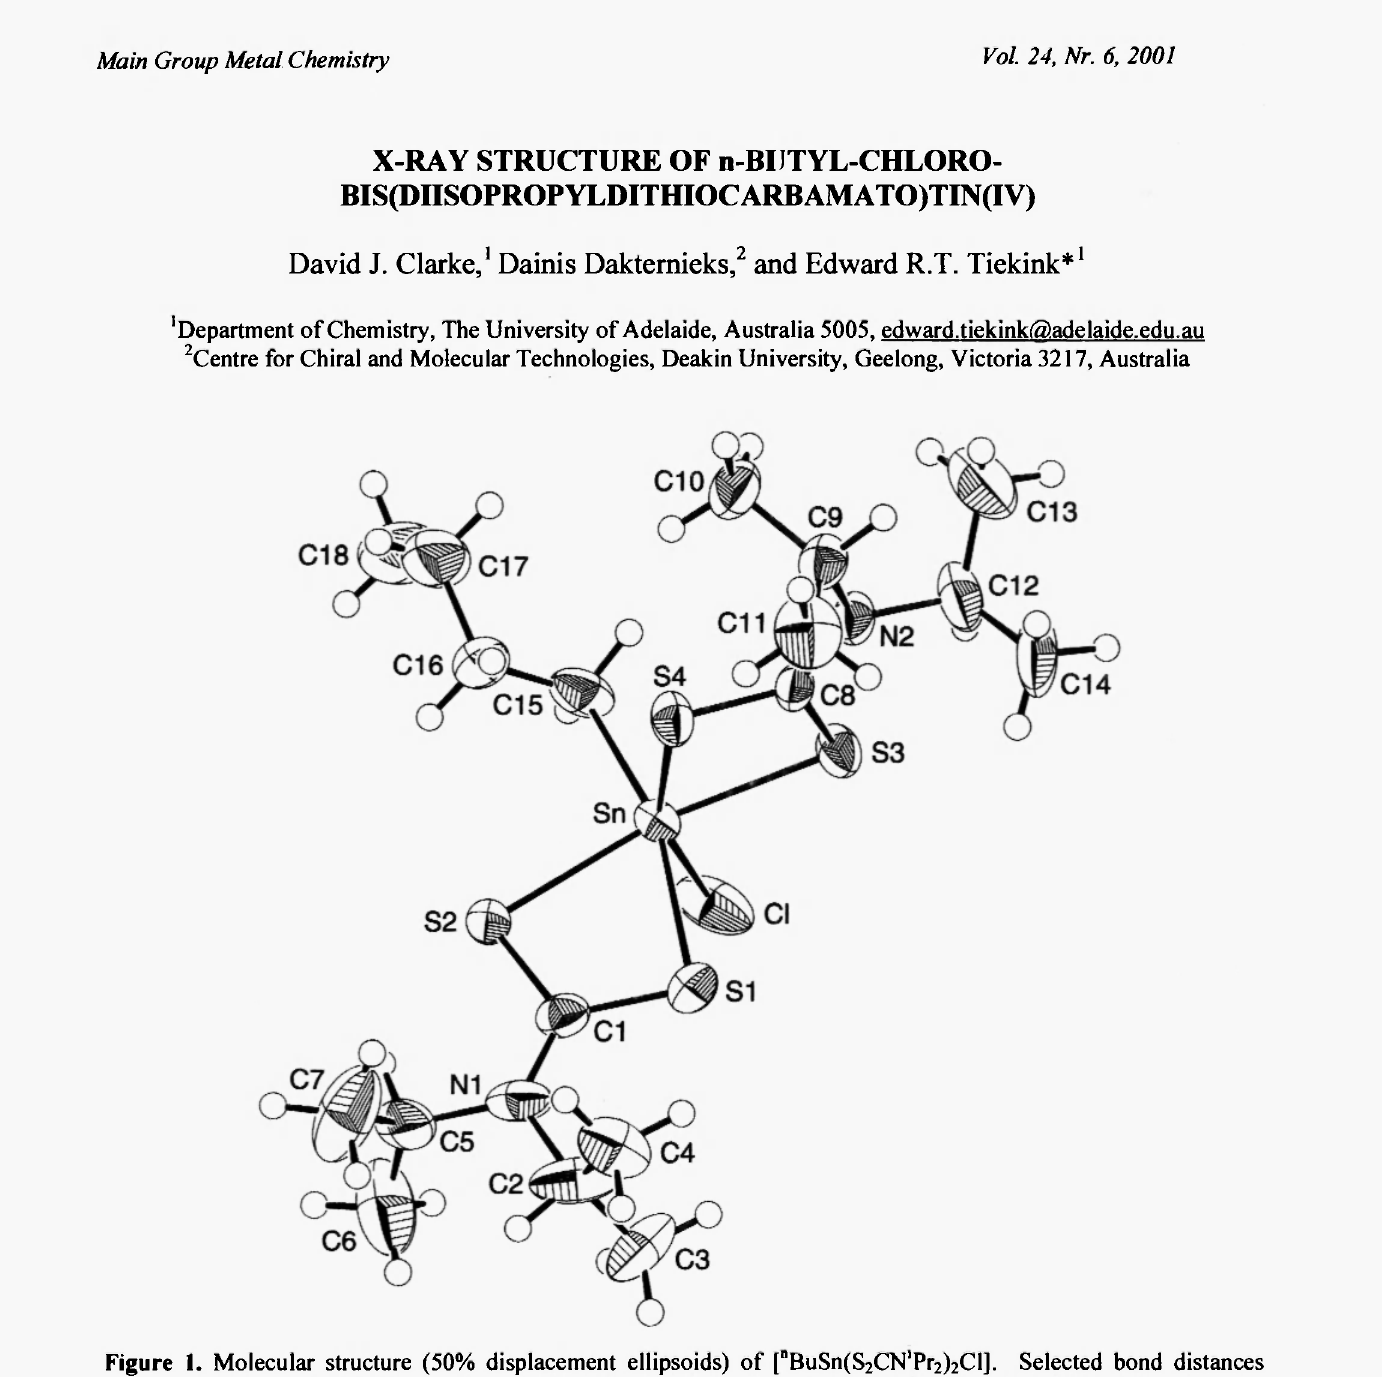
C8 88.3(2), Sn-S4-C8 85.4(2), S1-C1-S2 115.0(3) and S3-C8-S4